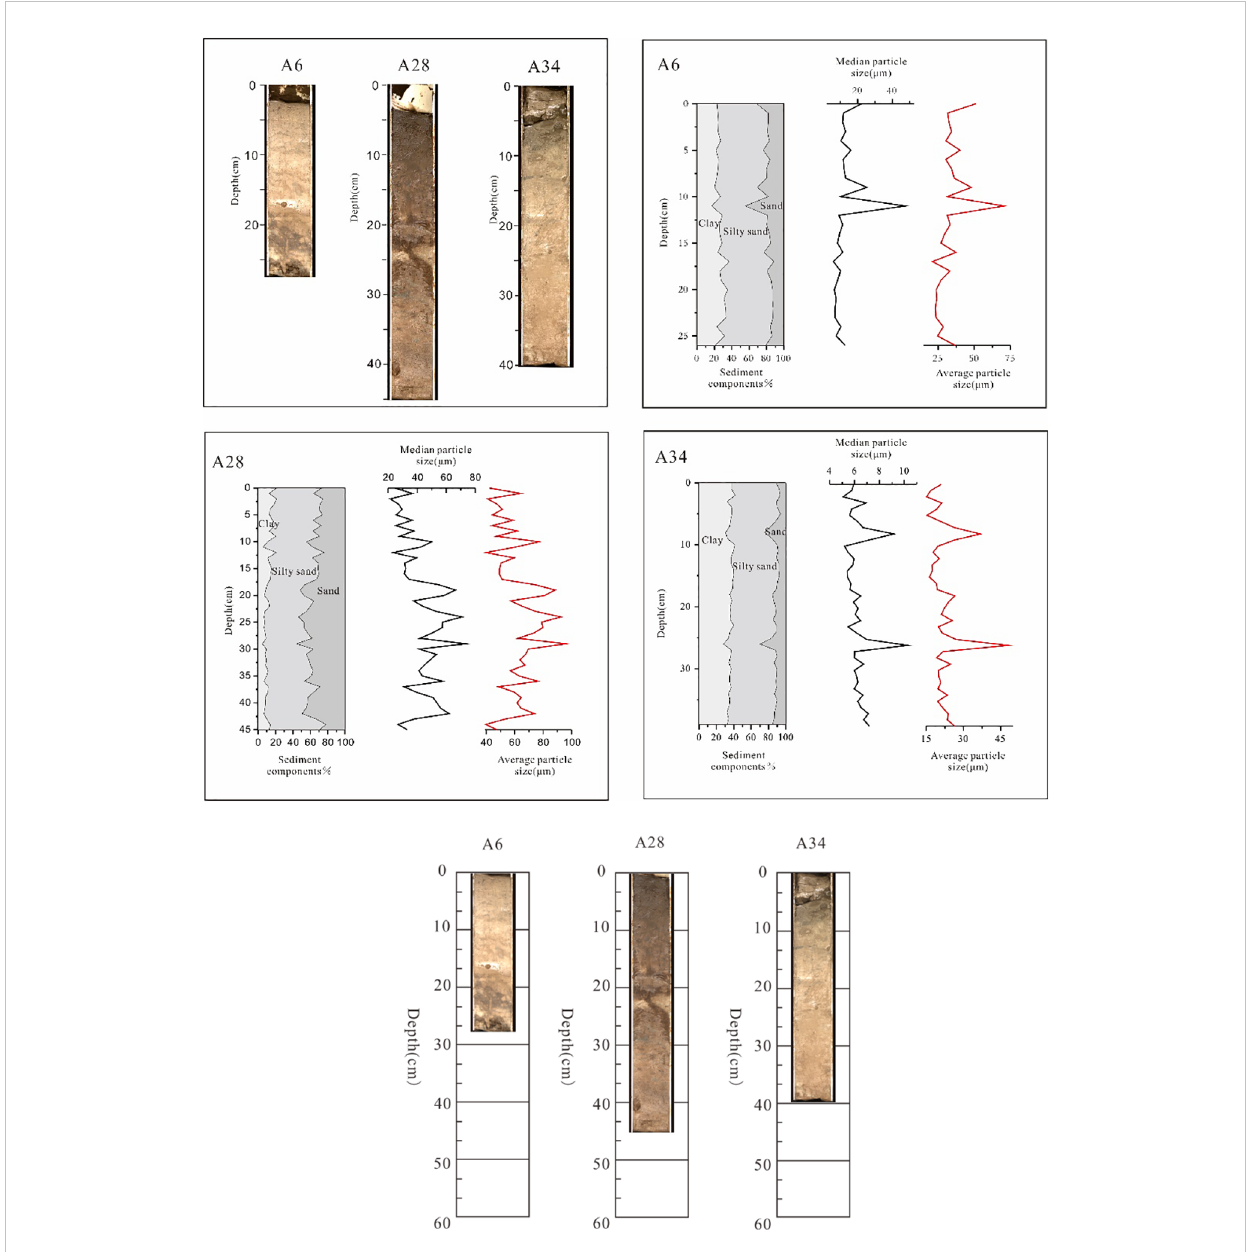
FIGURE 2 The sediment composition and particle size variability over core depth for A6, A28 and A34